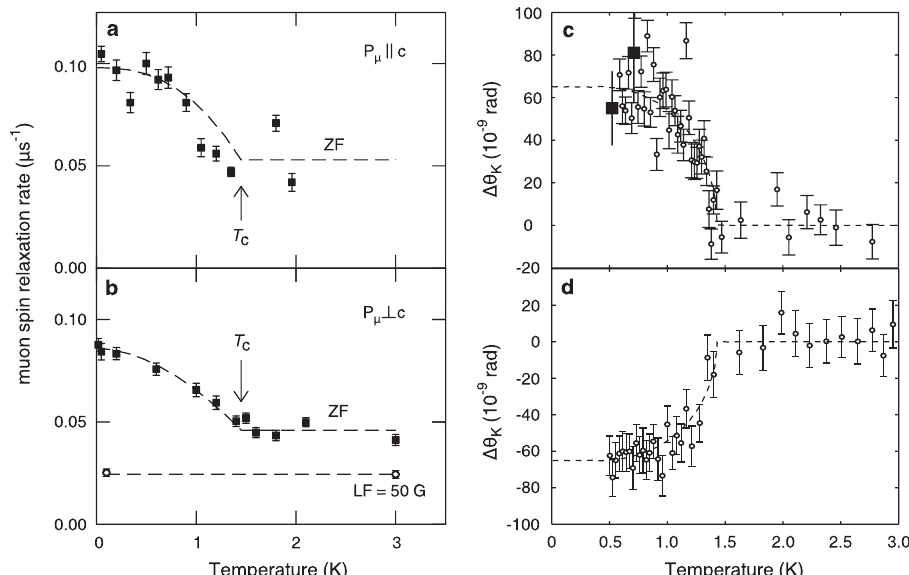
Fig. 3 a , b The muon relaxation rate for two muon polarisations is seen to increase at the onset of superconductivity in Sr 2 RuO 4 , interpreted as signalling the onset of spontaneous fi elds at defects in the bulk of the sample, due to the superconducting condensate breaking time reversal symmetry ( TRS ). 55 c , d In a second signal indicative of TRS breaking, a polar Kerr rotation has also been observed at T c . 56 The sign of the rotation can be trained by cooling in an external fi eld that is then switched off for the warming cycle ( a , b reproduced from ref. 55 copyright Macmillan 1998) ( c , d reproduced with permission from ref. 56 copyright